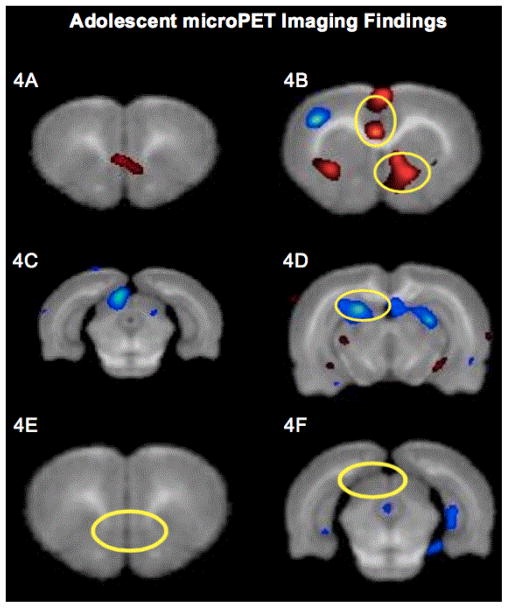
Adolescent microPET 18FDG Imaging Findings, PET images showing increased 18FDG uptake in infralimbic cortex (A) as well as nucleus accumbens and cingulate cortex; (B) of morphine group as compared to saline group (p<0.01) PET images showing decreased 18FDG uptake in superior colliculus; (C) and hippocampus (D) of morphine group as compared to saline group (p<0.01) PET images showing unaltered 18FDG uptake in infralimbic cortex; (E) and superior colliculus; (F) of morphine +GVG50 group as compared to morphine group (p>0.01).